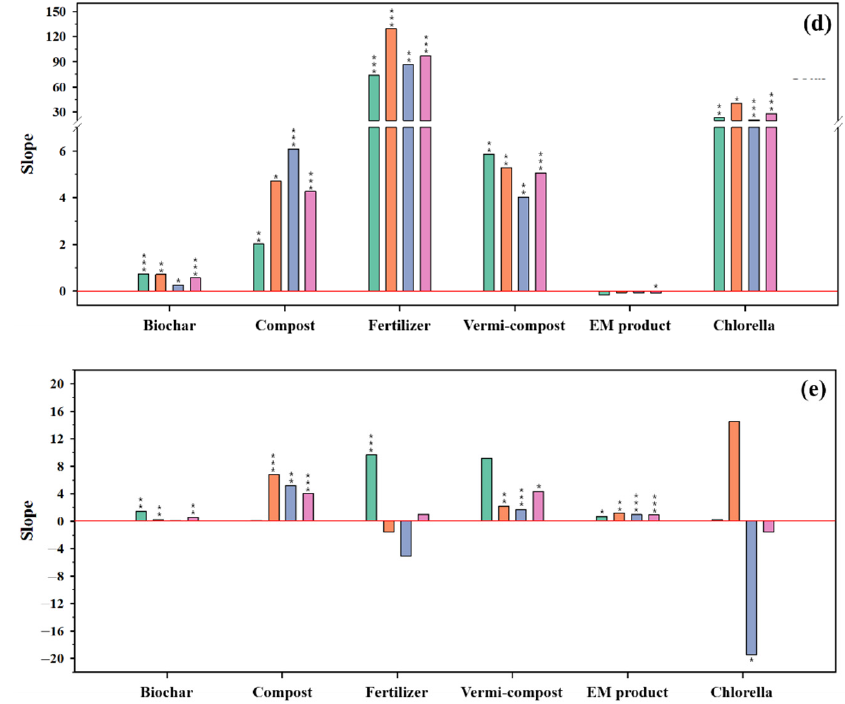
Figure 2. Results of the simple regression analyses according to the treatment periods. The first, second, and third periods’ mean after 2, 6, and 10 weeks. ( a ) Water holding capacity (WHC), ( b ) exchangeable K (Ex. K), ( c ) nitrate-nitrogen (NO3-N), ( d ) available phosphorus (Av. P), and ( e ) urease. * Significance ( p -value) ≤ 0.05, ** Significance ( p -value) ≤ 0.01, and *** Significance ( p -value) ≤ 0.001.